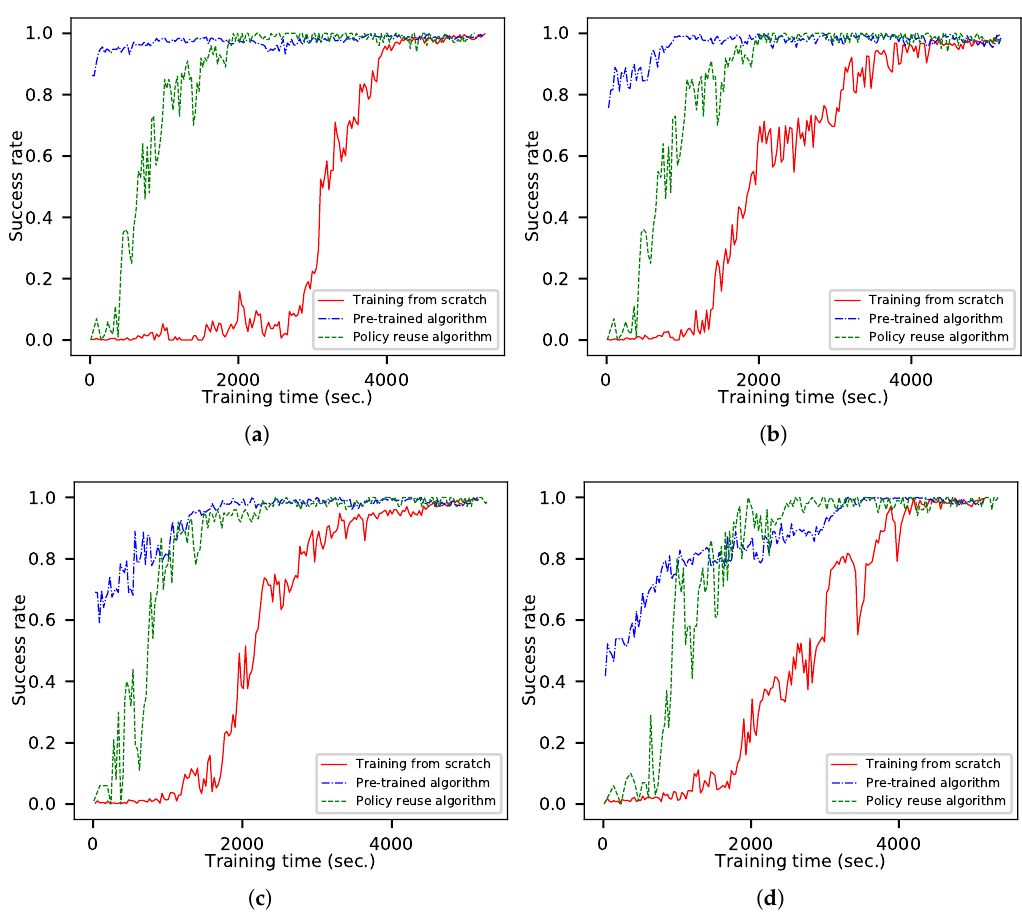
Figure 7. Policy reuse for agent training in uniform-motion destination scenario: destination speed of ( a ) 10 m/s, ( b ) 20 m/s, ( c ) 50 m/s and ( d ) 100 m/s.